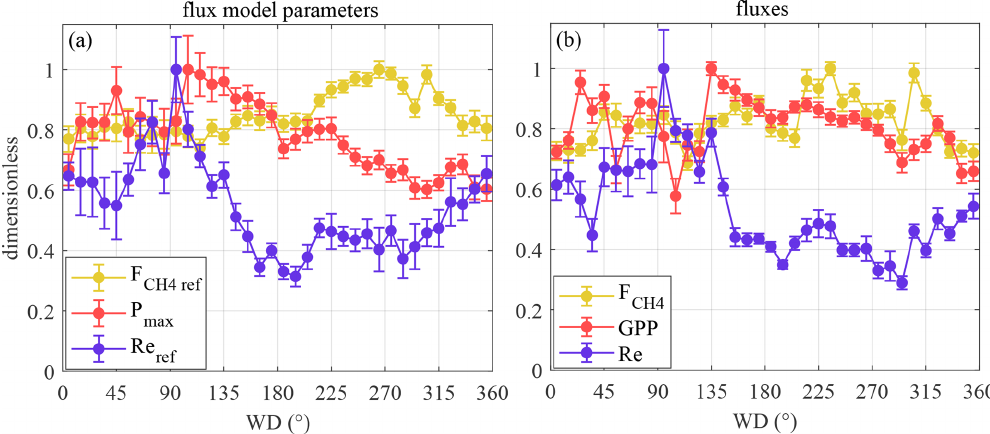
Figure 9. Variation in June–August fluxes and flux model parameters with wind direction. (a) Variation in the CO 2 and CH 4 flux model parameters; (b) measured fluxes. The markers are bin averages normalized by the highest bin-average value for